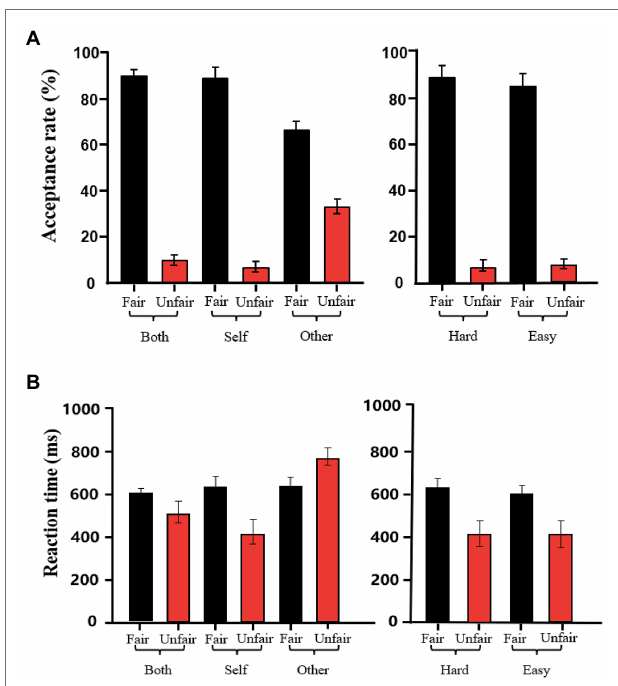
FIGURE 2 | Comparisons of behavioral parameters across conditions. (A) Acceptance rates. (B) Reaction times. All data are presented as the mean ±